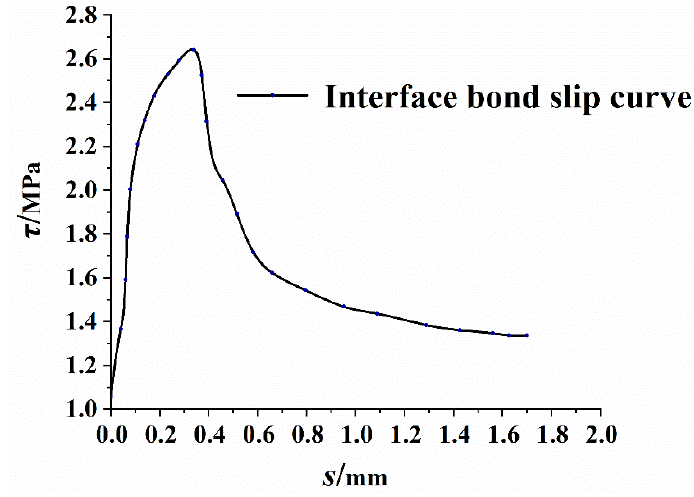
Figure 6. Interface bond strength-slip relationship (Bu Liang-tao, 2018).